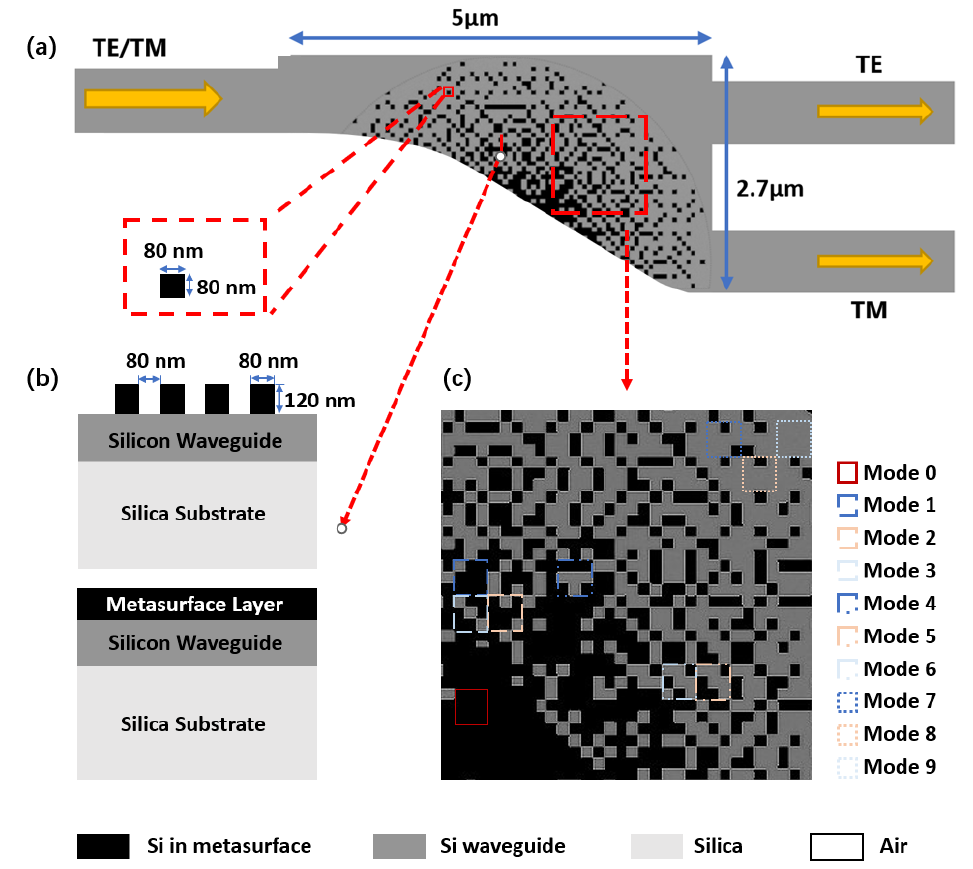
Figure 1. Schematic of the metasurface polarization beam splitter. ( a ) Top view of the proposed PBS. Inset: the zoom-in top view of a single pixel in the metasurface layer. ( b ) Cross-section of the area marked by the red line, which indicates the structural form of metasurface built on the standard SOI. The topmost metasurface layer can be divided into a series of small pixels of 80 × 80 nm 2 , each of which has two optional modes: etched air hole or silicon. ( c ) The metasurface structure, in which the light area represents the doped air, and the dark area represents the 120 nm thick silicon structure.